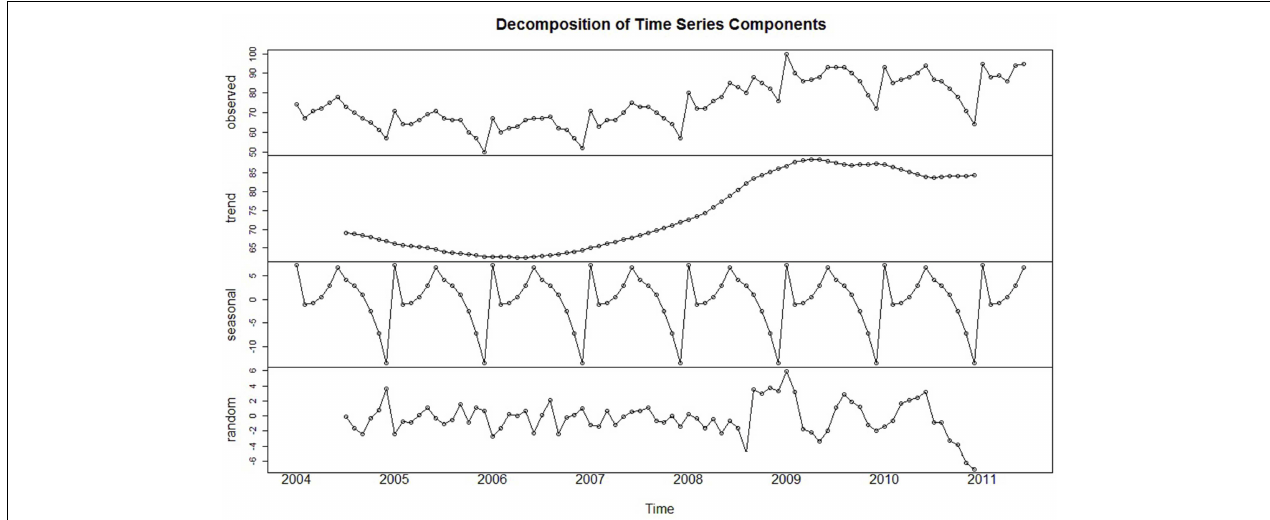
FIGURE 2 | The original time series decomposed into its trend, seasonal, and irregular (i.e., random) components. Cyclical effects are not present within this series.